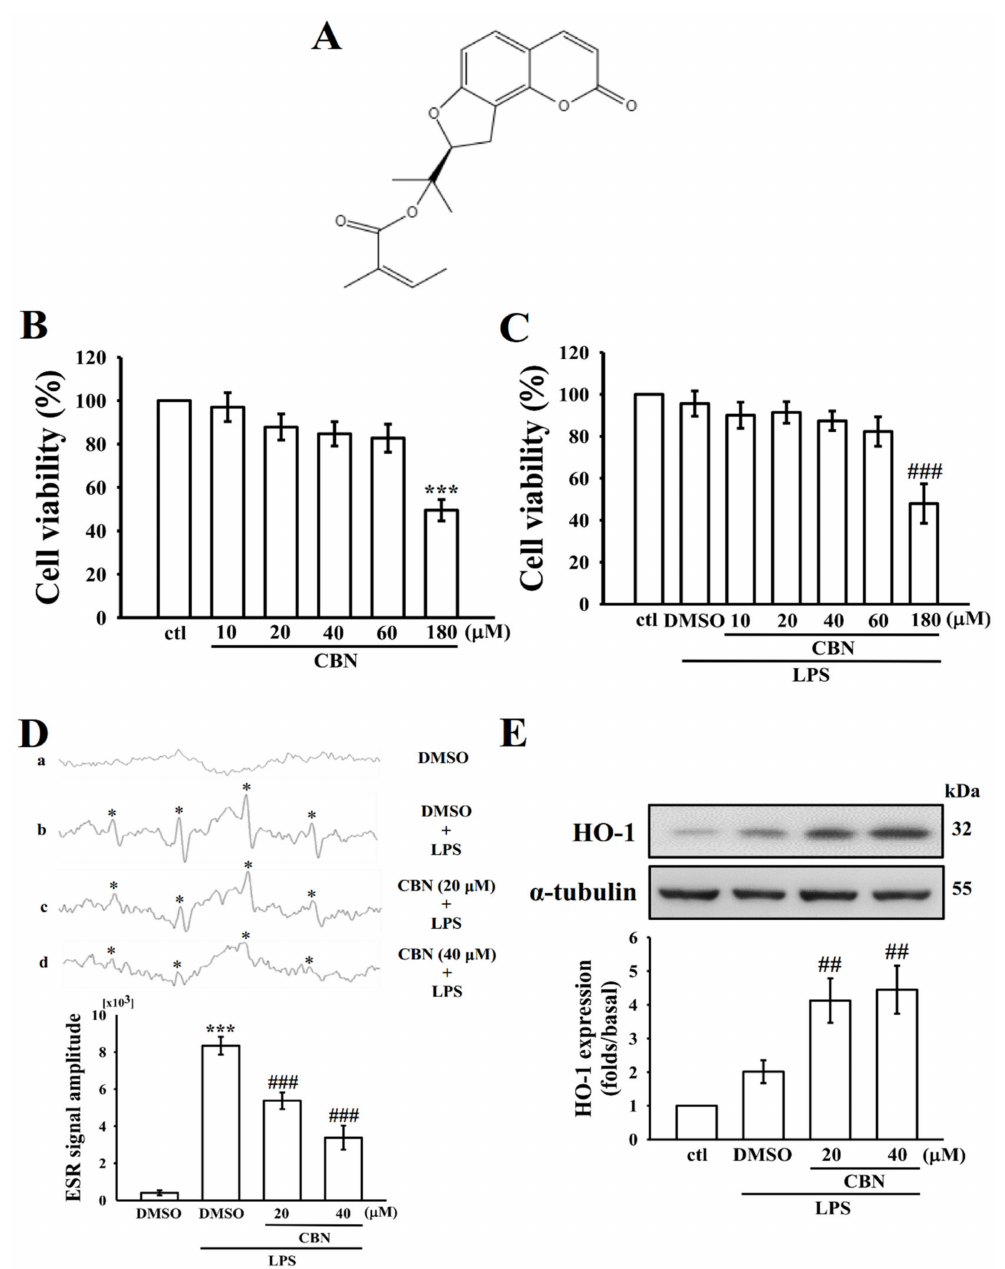
Figure 1. Effect of columbianadin (CBN) on lipopolysaccharide (LPS)-stimulated cytotoxicity, • OH production, and HO-1 expression in RAW 264.7 macrophages. ( A ) The chemical structure of columbianidin (CBN; C 19 H 20 O 5 , molecu- lar weight 328.36). ( B , C ) The cell viability of CBN (10–180 µ M) alone ( B ) or combined with LPS ( C ) as shown in the Materials and Methods section. ( D ) All the reaction mixtures contained (a) 0.1% DMSO, (b) LPS + DMSO, (c and d) CBN (20 and 40 µ M) + LPS (1 µ g/mL). Radical signal intensity was detected by electron spin resonance (ESR) spectropho- tometry. An asterisk (*) indicates the formation of • OH radicals. The statistical significance was calculated from the average values of four identified peaks using WIN-EPR version 921201. ( E ) Cells were treated with 0.1% DMSO or CBN (20–40 µ M) for 20 min, and then induced by LPS (1 µ g/mL) for 24 h to detect HO-1 expression by immunoblotting. Data presented are the means ± S.E.M. ( n = 4); *** p < 0.001 compared with the control cells; ## p < 0.01 and ### p < 0.001 compared to LPS-induced